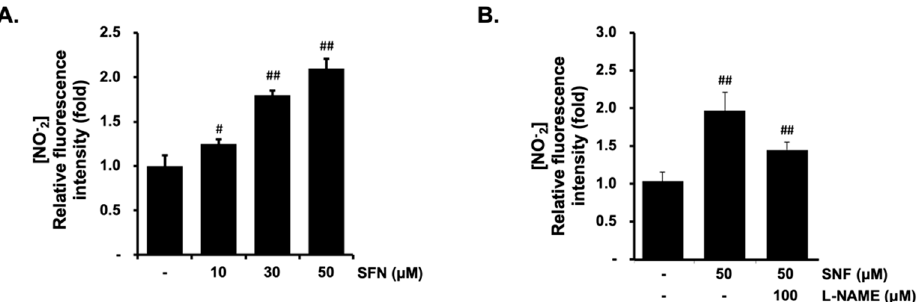
Figure 2. SFN increases NO production in EA.hy926 cells. Cells with 95% confluence in the chamber slides were grown and starved overnight. The cells were treated with DAF-2 or DAF-2DA with a final concentration of 1 μ M for 30 min at 37 °C, rinsed three times with DMEM, and incubated in the dark, followed by treatment of SFN at the indicated concentrations without ( A ) or with ( B ) L-NAME (100 μ M), which was added 30 min ahead of DAF-2DA treatment. The samples continued to be incubated for 24 h. NO production was determined by spectrofluorometer at peak excitation and emission wavelengths of 495 nm and 515 nm, respectively. The data represent the mean ± standard deviation from triplicate measurements. # p < 0.05; ## p < 0.01 versus control.